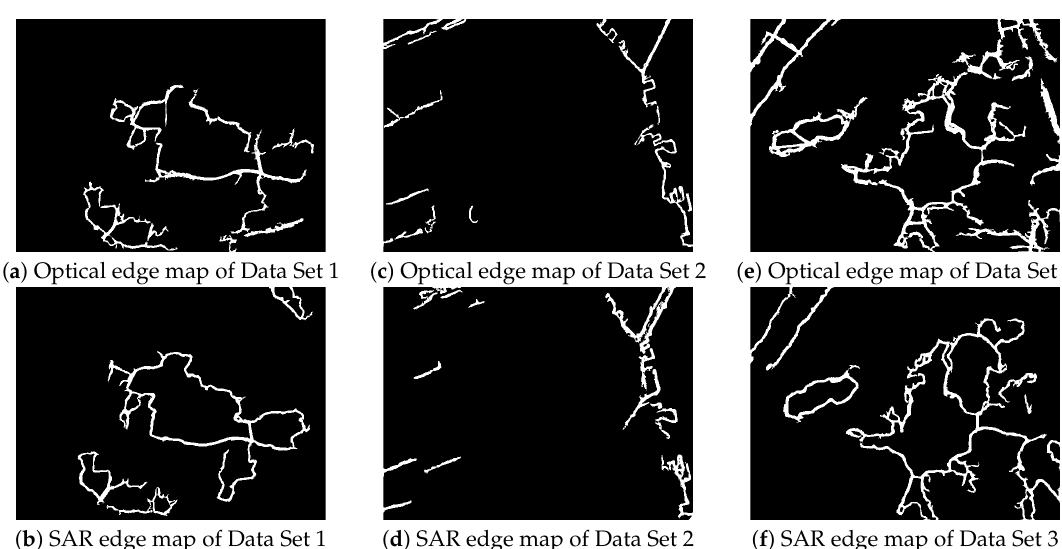
Figure 10. Binary edge maps of the experimental data.